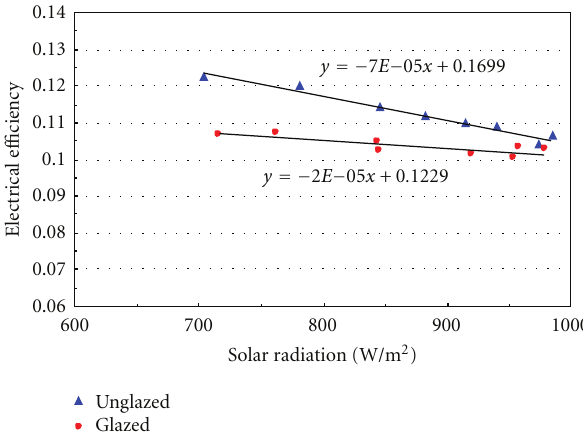
Figure 13: Electrical e ffi ciency of the glazed and unglazed PVT collectors as a function of solar radiation ( T i = 40 ◦